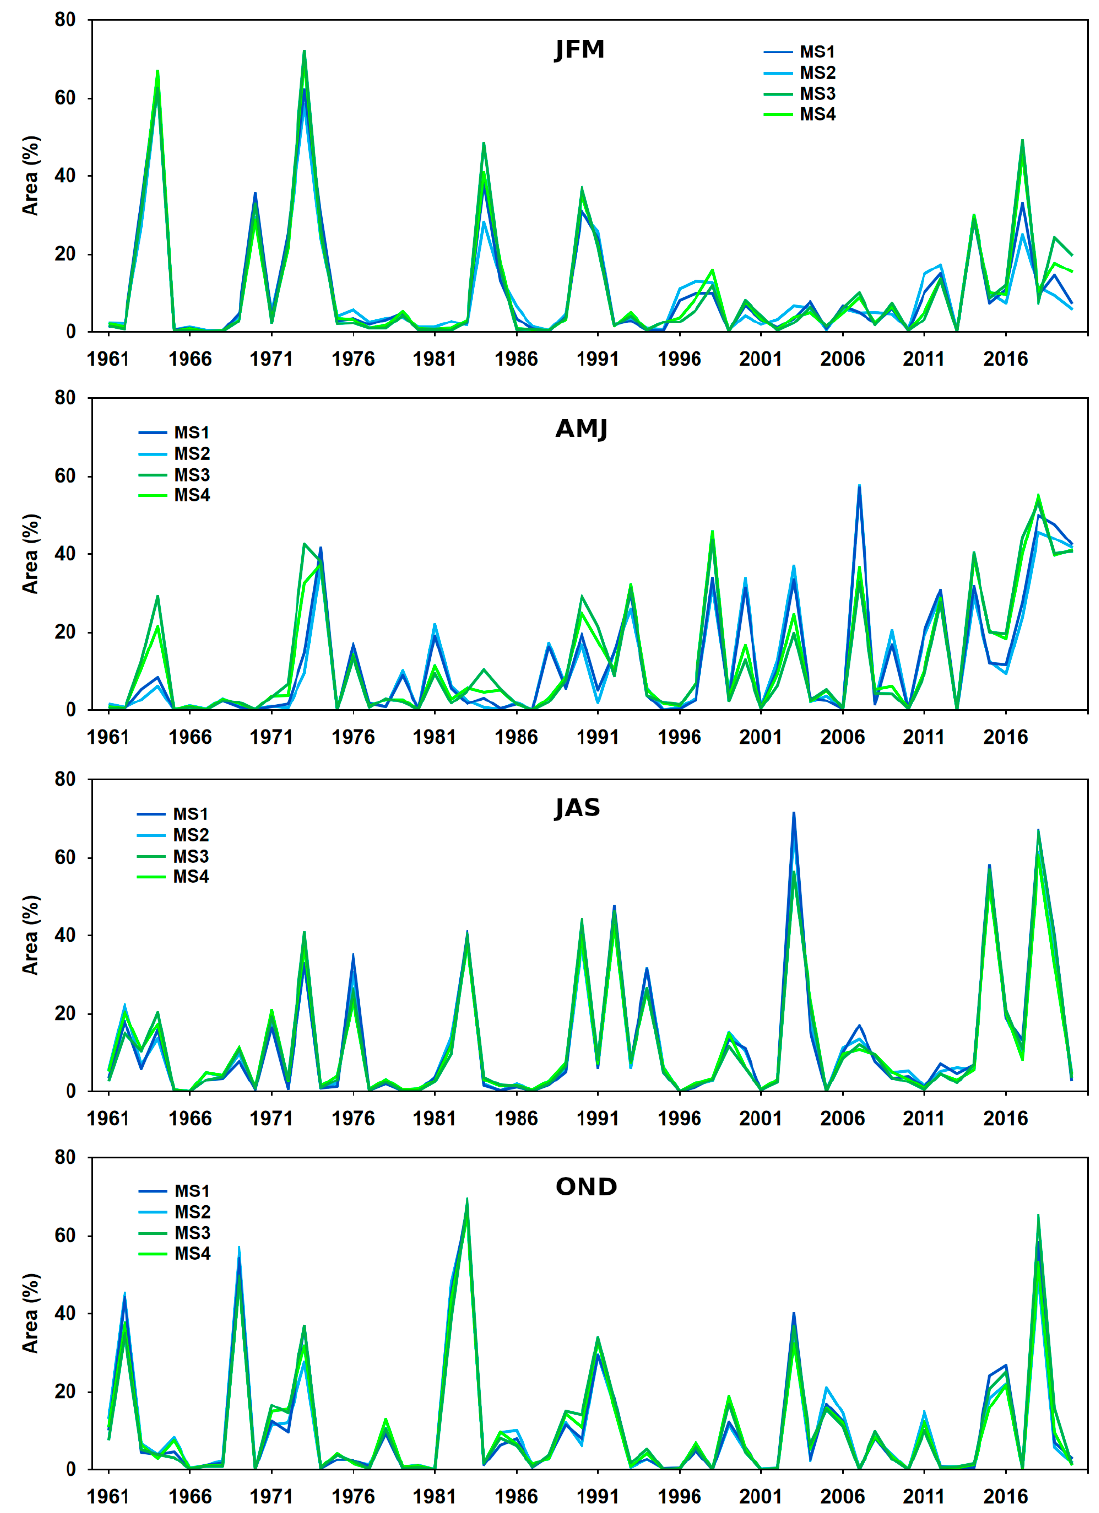
Figure 3. Fluctuations in the area exhibiting 10th-percentile soil drought (% of grid points) in the 0–100 cm soil layer in the Czech Republic, according to four different SoilClim model setups (MS1–MS4) for JFM, AMJ, JAS, and OND in the 1961–2020 period.